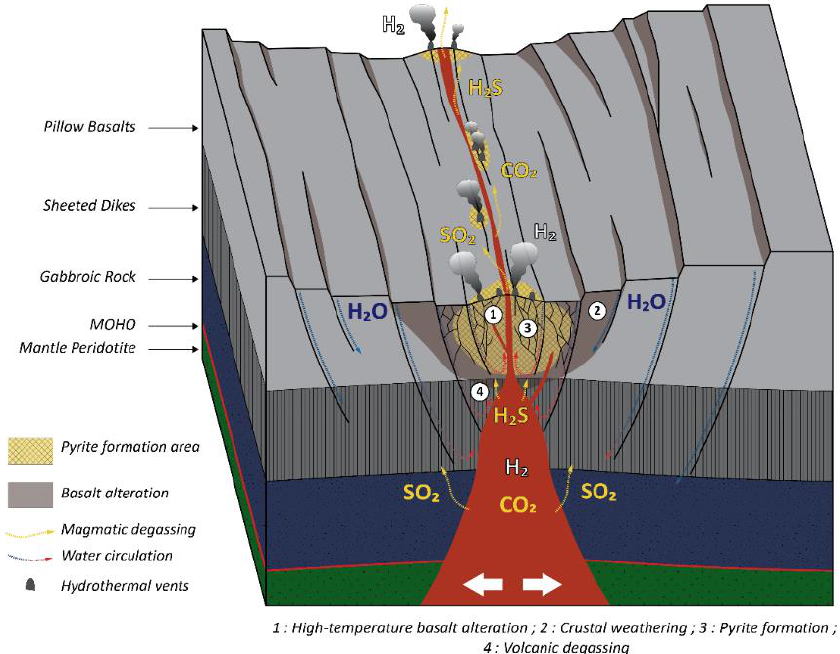
Figure 2. Simplified model of gas production and reaction along an accretionary axis. 1—High-temperature basalt alteration: 3(Fe 2 SiO 4 ) rock + 2H 2 O → 3SiO 2 + 2Fe 3 O 4 + 2H 2 ; 2—Crustal weathering: 2Fe rock + H 2 O → Fe 2 O 3(rock) + H 2 ; 3—Pyrite formation: FeS + H 2 S → FeS 2 + H 2 ; 4—Volcanic degassing: SO 2 + 3H 2 → H 2 S + 2H 2 O. (After [42–44]).